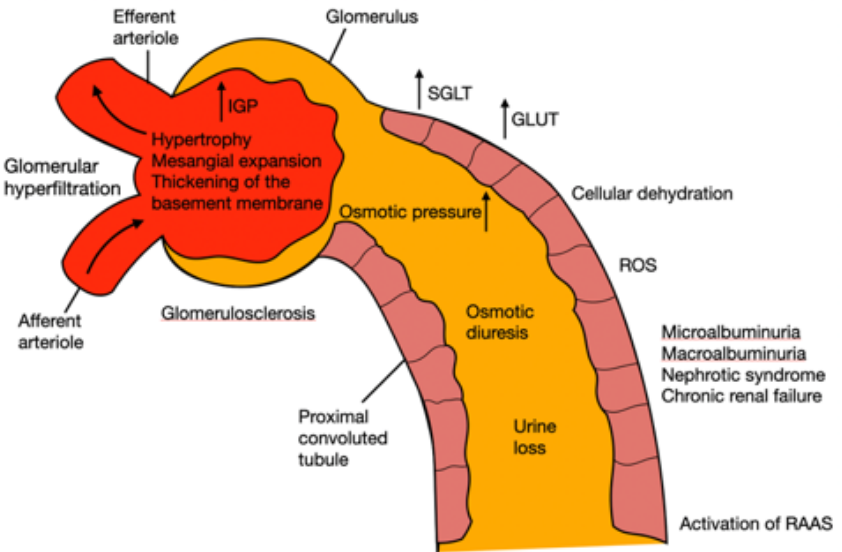
Figure 2. Pathophysiology of kidney damage induced by diabetes. IGP: intraglomerular pressure; SGLT: sodium-glucose transporter; GLUT: glucose transporter; RAAS: renin angiotensin aldosterone system.